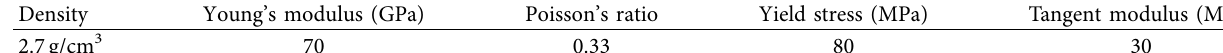
Table 7: Matrix material parameters.